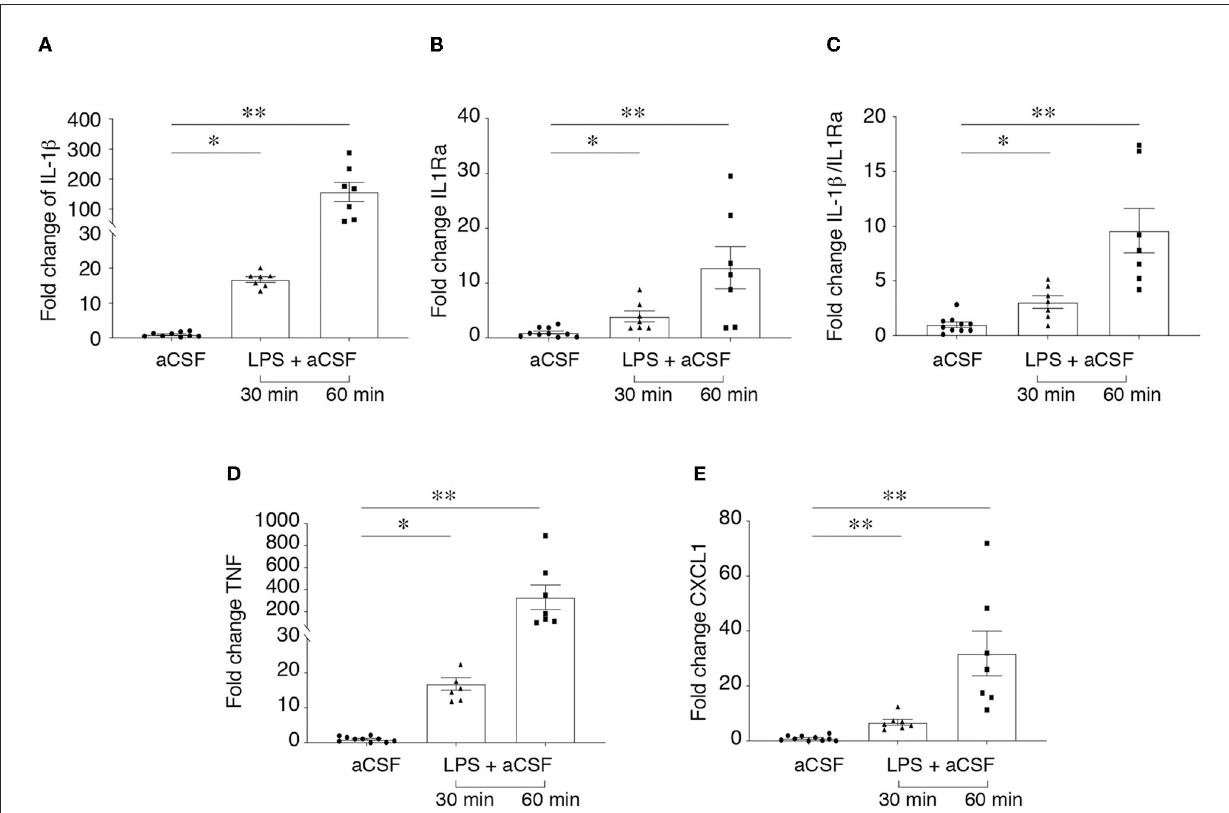
FIGURE1 LPS-induced neuroinflammation in hippocampus/temporal cortex slices. RT-qPCR analysis of cytokine mRNA (A–E) in hippocampal/temporal cortex slices incubated with aCSF alone or with 10 µ g/ml LPS for 30min, followed by 30min or 60min washout in aCSF. Reference genes were s2Vb and Actb . Data are presented as fold-increase vs. control value in aCSF incubated slices (mean ± SEM and single values). * p < 0.05, ** p < 0.01 vs. aCSF by Kruskal–Wallis test followed by Dunn’s multiple comparison